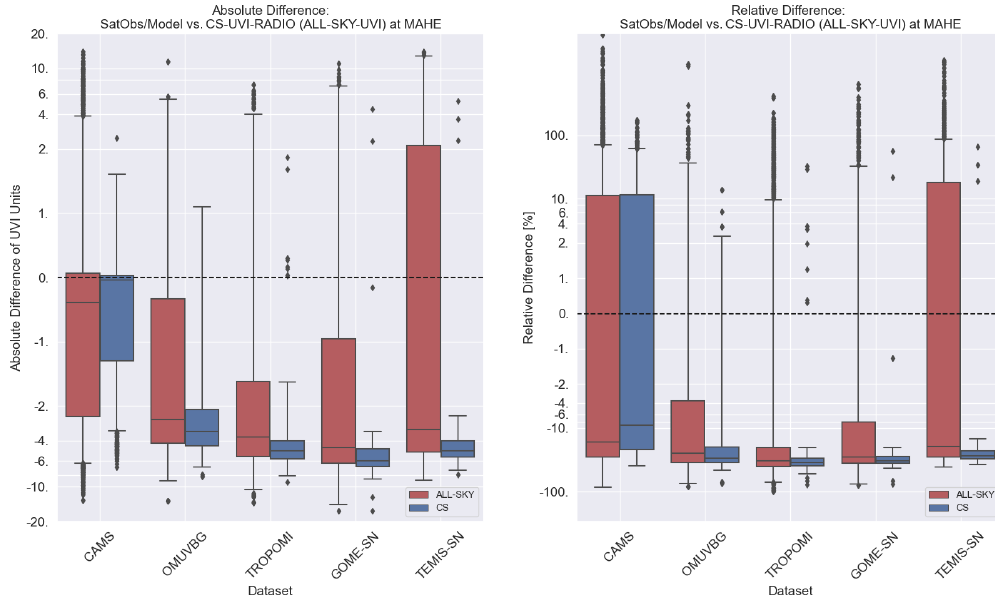
Figure A6. Boxplot of differences between UVI-RADIO and satellite/model estimates at Mahé.